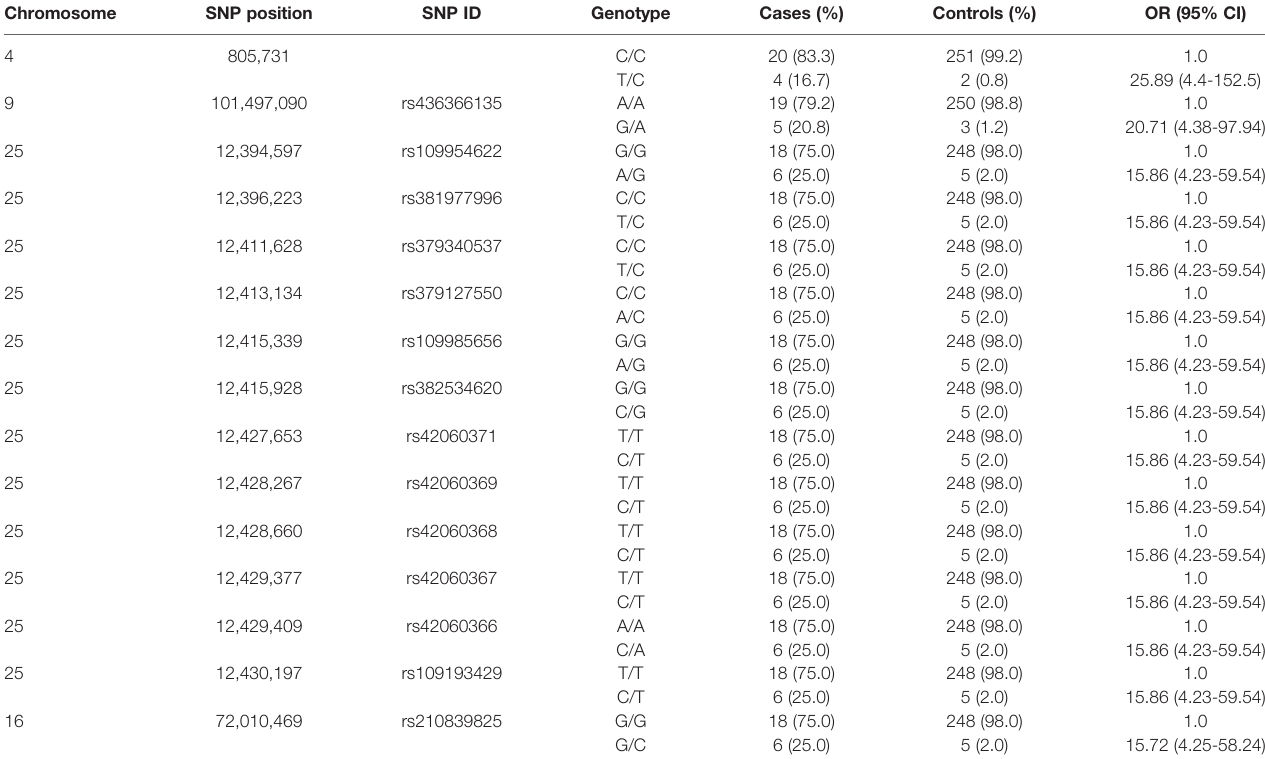
TABLE 2 | Frequency of cases and controls and odds ratio (OR) under the additive genetic model for the 15-top SNPs associated with tolerance (FDR ≤ 0.05, P < 5 × 10 -7 ). Chromosome SNP position SNP